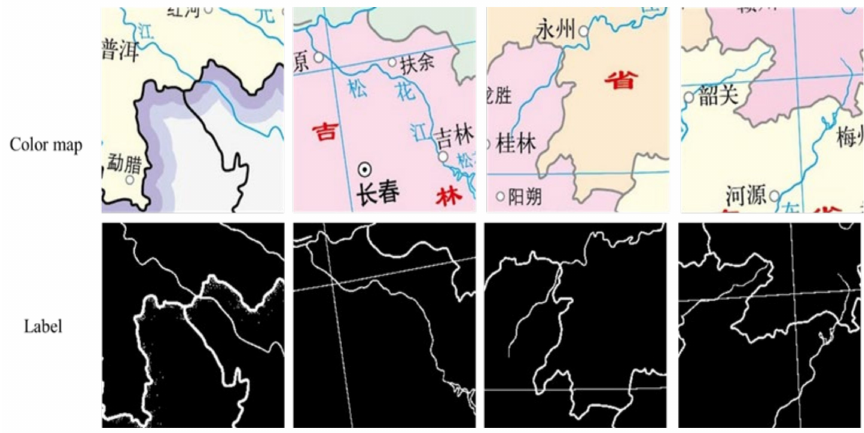
Figure 2. The map